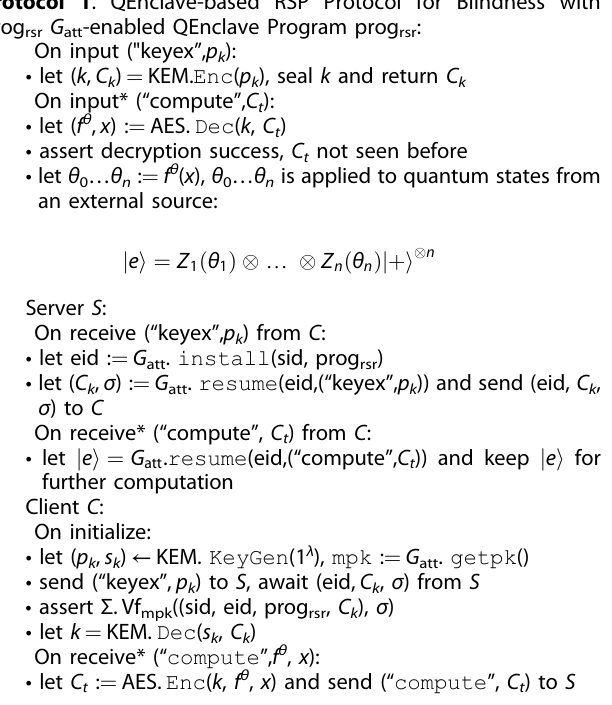
Protocol 1 . QEnclave-based RSP Protocol for Blindness with prog